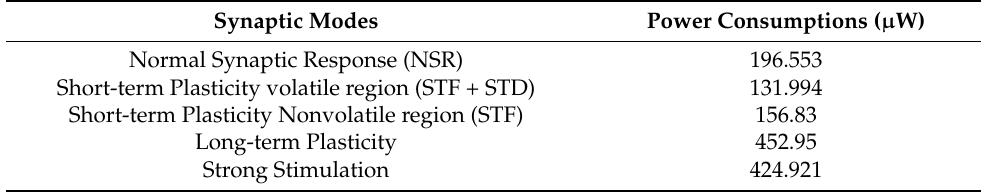
Table 3. Power consumption of different synaptic modes of the neuro-memristive synapse.